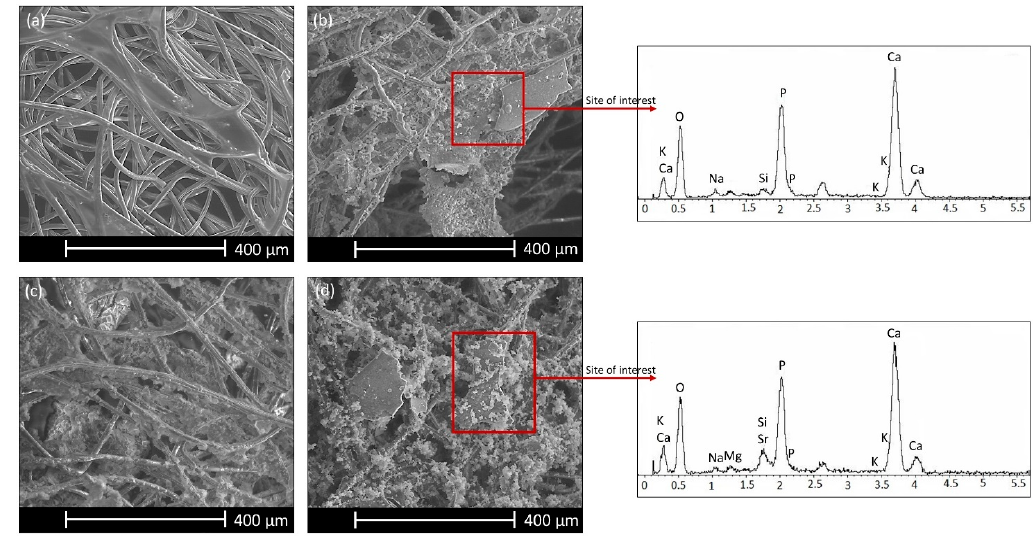
Figure 4. SEM images and EDS spectra 7 days after immersion in SBF solution of CHT ( a ), CHT45S5_10 ( b ), CHTZn10 ( c ), and CHTSrMg10 ( d ) wound dressings. SEM images of CHT45S5_10 and CHTSrMg10 (Figure 4b,d) confirm the presence of HCA